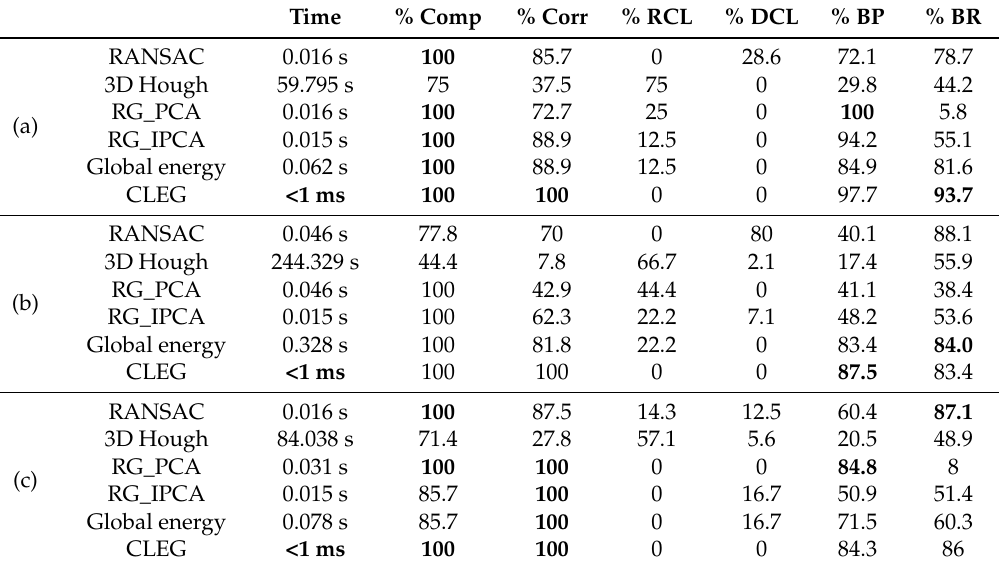
Table 3. Quality of the segmentation results in the Vaihingen area.